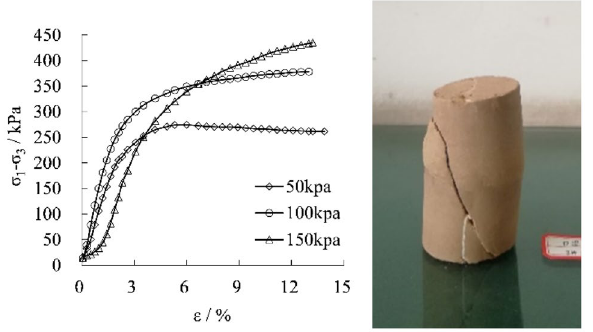
Figure 4. The stress–strain curve of vertical joint samples by triaxial compression test and typical failure characteristics.